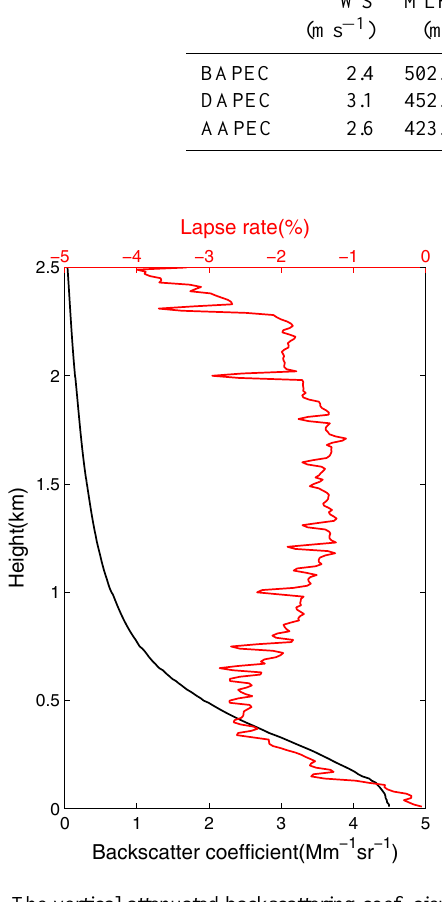
Figure 6. The vertical attenuated backscattering coefficient profile and the lapse